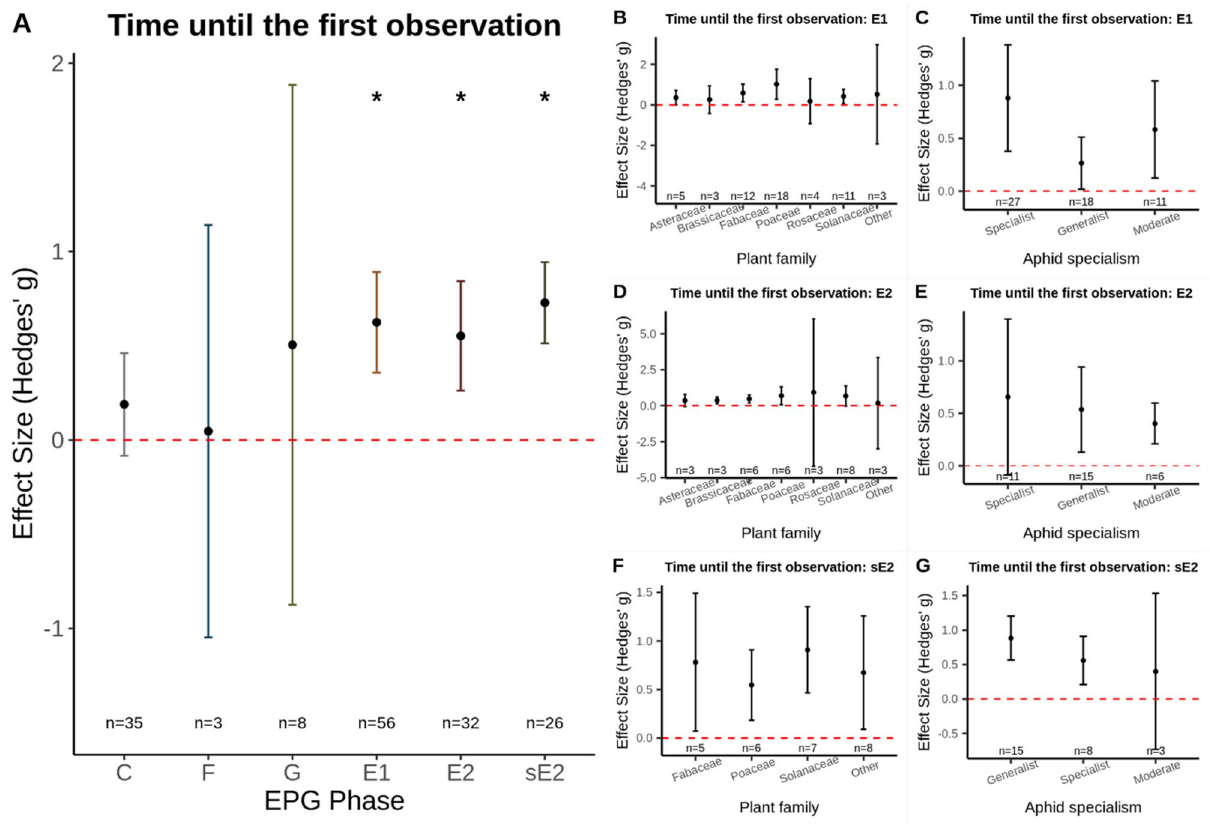
Figure 2. ( A ) The mean effect size for each EPG phase for the aphid “Time to First Event” dataset; *EPG phases significantly impacted by plant resistance. ( B – G ) sub-group analysis for the three EPG phases where time to first detection was significantly different between aphids feeding on susceptible vs. resistant plants. Time to first E1 ( B , C ), time to first E2 ( D , E ), and time to first sE2 ( F , G ). Sub-group analysis was done for plant family ( B , D , F ) and aphid specialism ( C , E , G ). Graphs displays the mean effect size (Hedges’ g) and the 95% confidence intervals. Red dashed line displays the zero effect